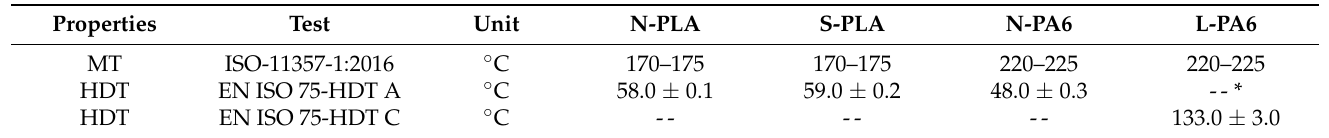
Table 2. Injection-moulded material thermal test data. Melting temperature (MT), heat deflection temperature (HDT).